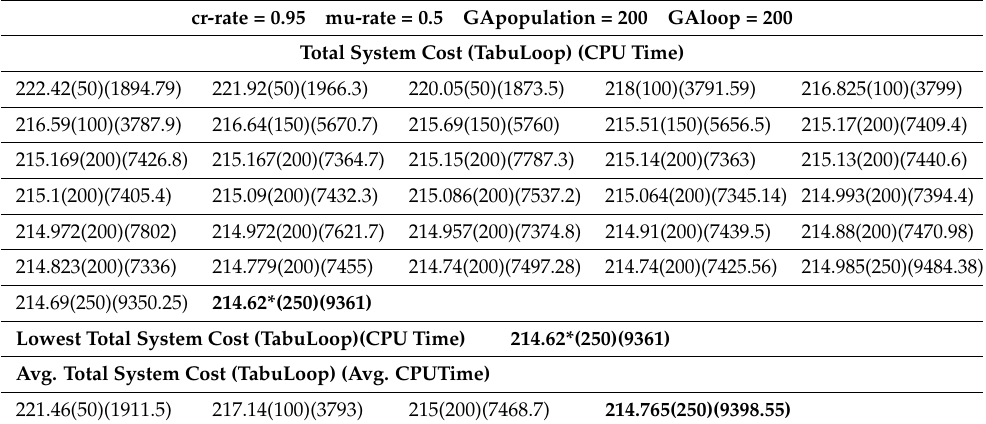
Table 17. The total system costs of 32 simulation runs obtained by TA–MGA for the parallel-series system. cr-rate = 0.95 mu-rate = 0.5 GApopulation = 200 GAloop = 200 Total System Cost (TabuLoop) (CPU Time)